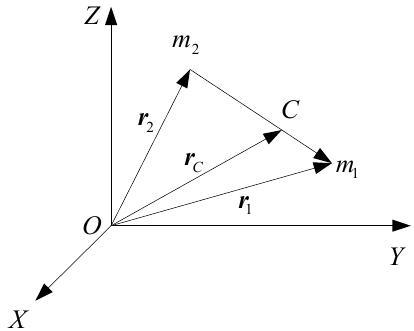
Figure 1. The two-body motion model used in this study. r is the position vector.